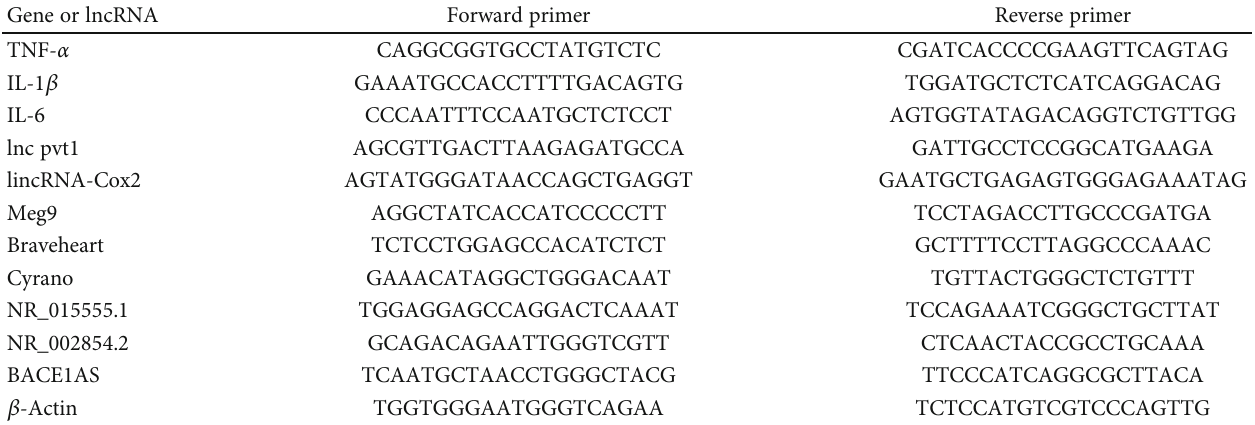
Table 1: qRT-PCR primers